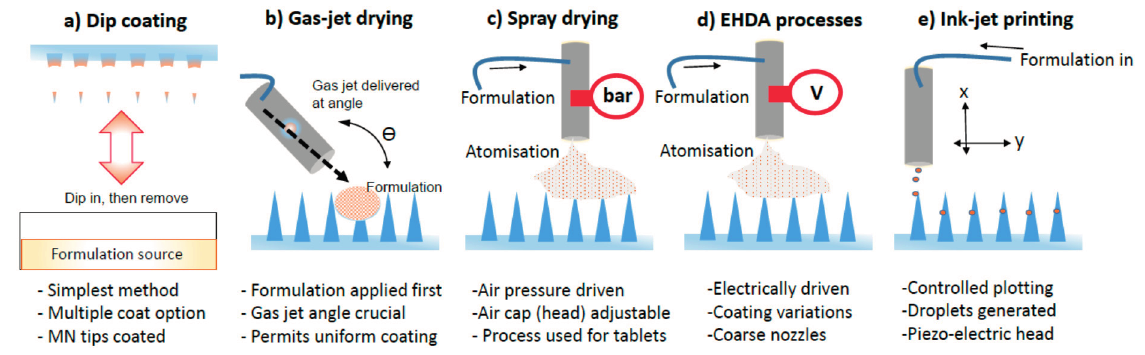
Figure 1. Illustrated examples of techniques used to coat MNs. ( a ) Dip coating; ( b ) Gas-jet drying; ( c ) Spray drying; ( d ) EHDA processes; ( e ) Ink-jet